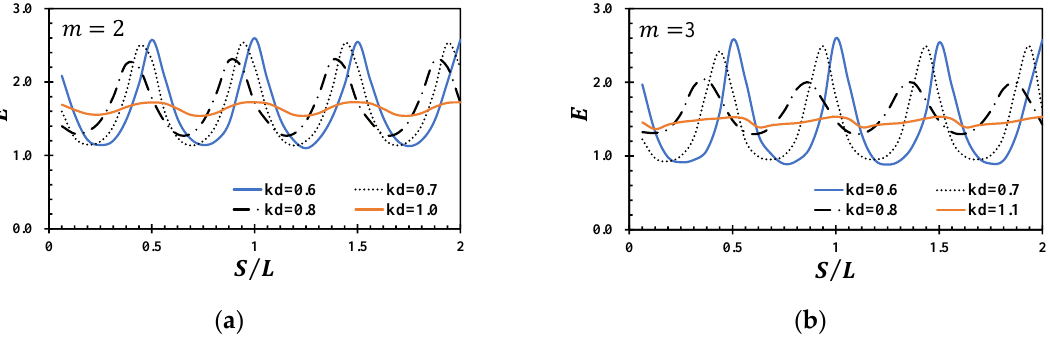
Figure 13. Variation of the enhancement coefficient E with S / L for the different wave periods kd . ( a ) m = 2. ( b ) m = 3.